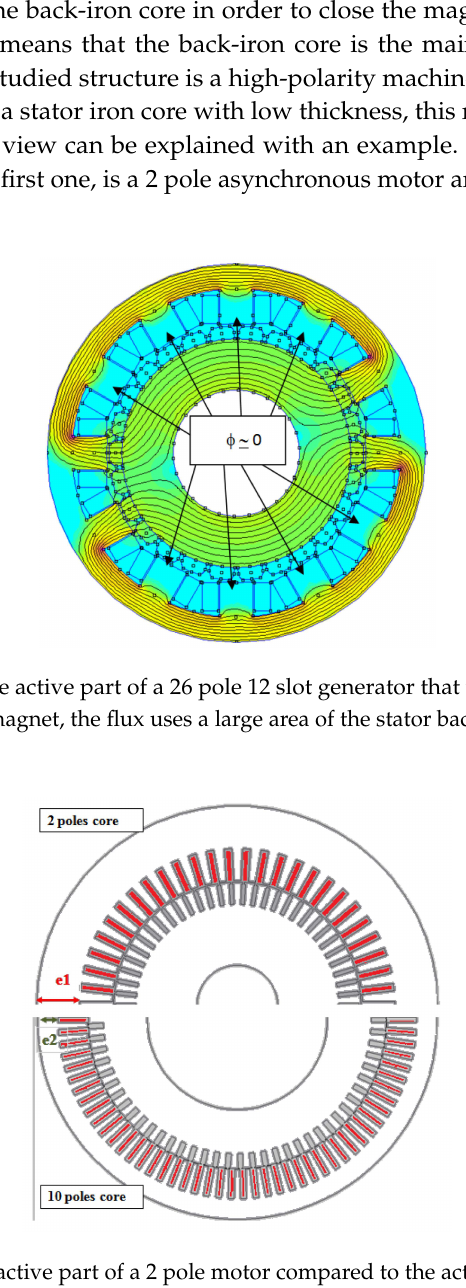
Figure 13. Schemes of the active part of a 2 pole motor compared to the active parts of a 10 pole motor. e1 and e2 are the back-iron core thicknesses (e1 >> e2) and both of them use distributed